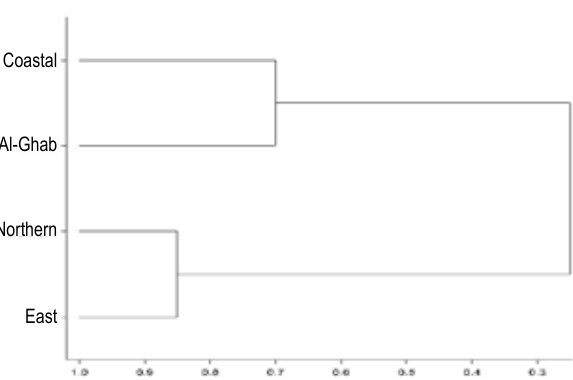
Figure 3. Dendrogram of genetic distance for virulent and distribution Puccinia triticina races in Syria in 2010.